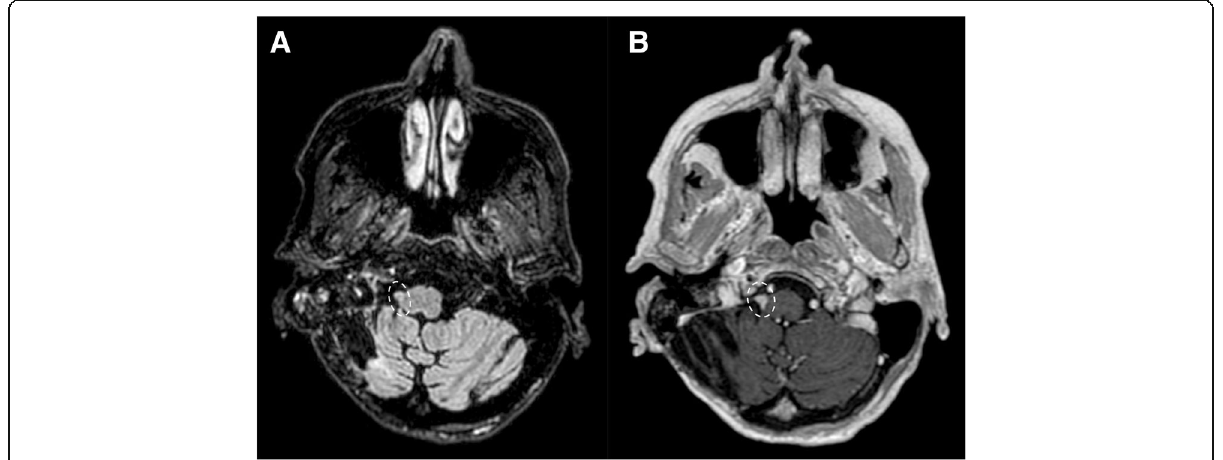
Fig. 16 Small glossopharyngeal neurofibroma. Patient with NF1. MRI FLAIR ( a ) and T1 post-gadolinium ( b ) sequences, axial plane, demonstrate a mildly hyperintense small lesion (dotted circles) with avid enhancement located on the right post-olivary sulcus